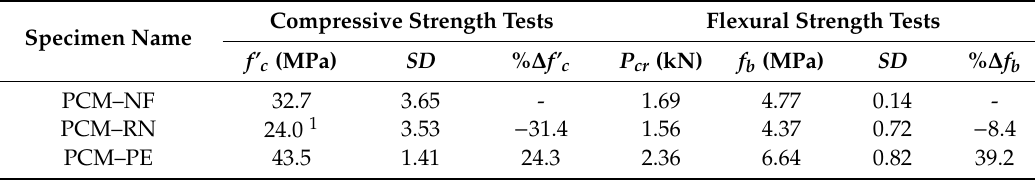
Table 5. Compressive strength tests and flexural strength tests results.